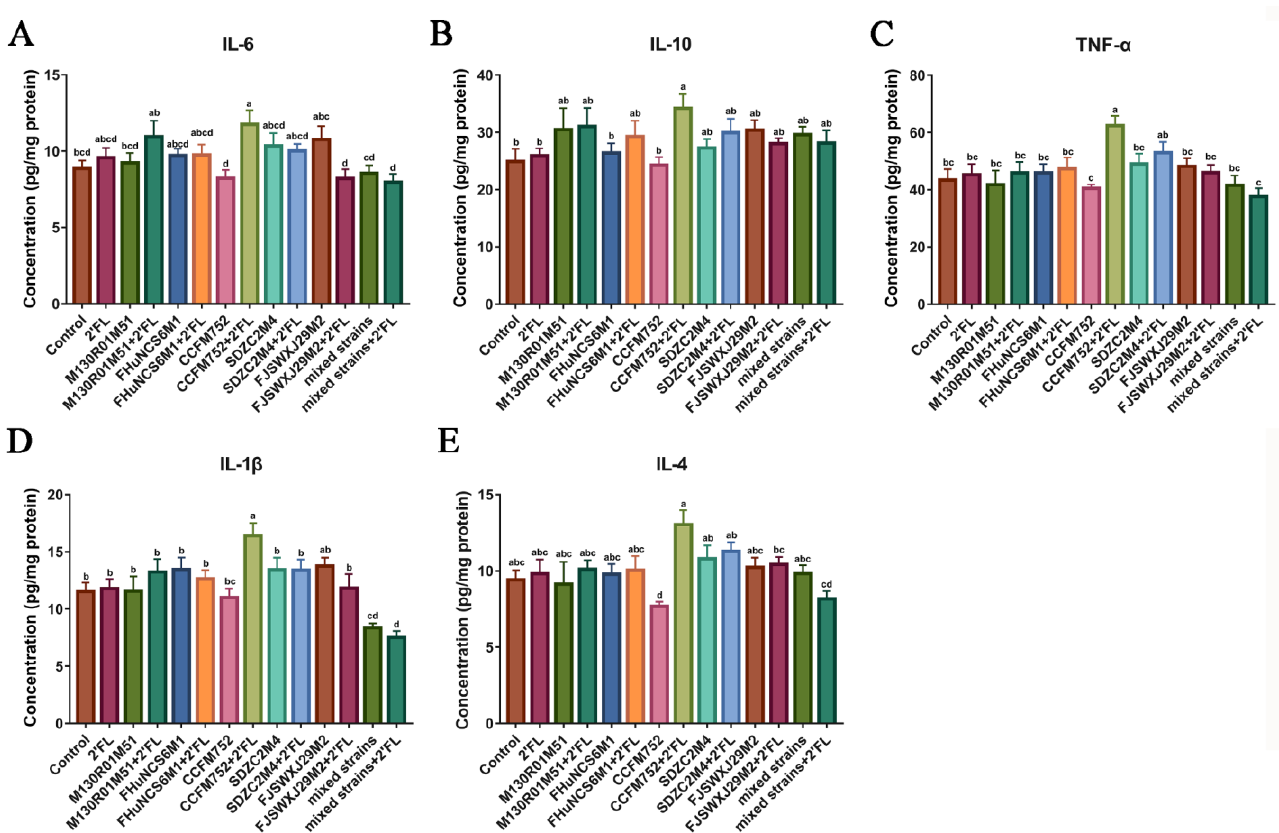
Figure 3. Effects of Bifidobacterium with different utilization of 2 ′ FL on the concentration of cytokines in mice colon tissue (n = 8). ( A ) IL-6, ( B ) IL-10, ( C ) TNF- α ( D ) IL-1 β , and ( E ) IL-4. Statistical differences were calculated by ANOVA followed by Duncan analysis and different letters indicate significant differences between the groups ( p < 0.05).